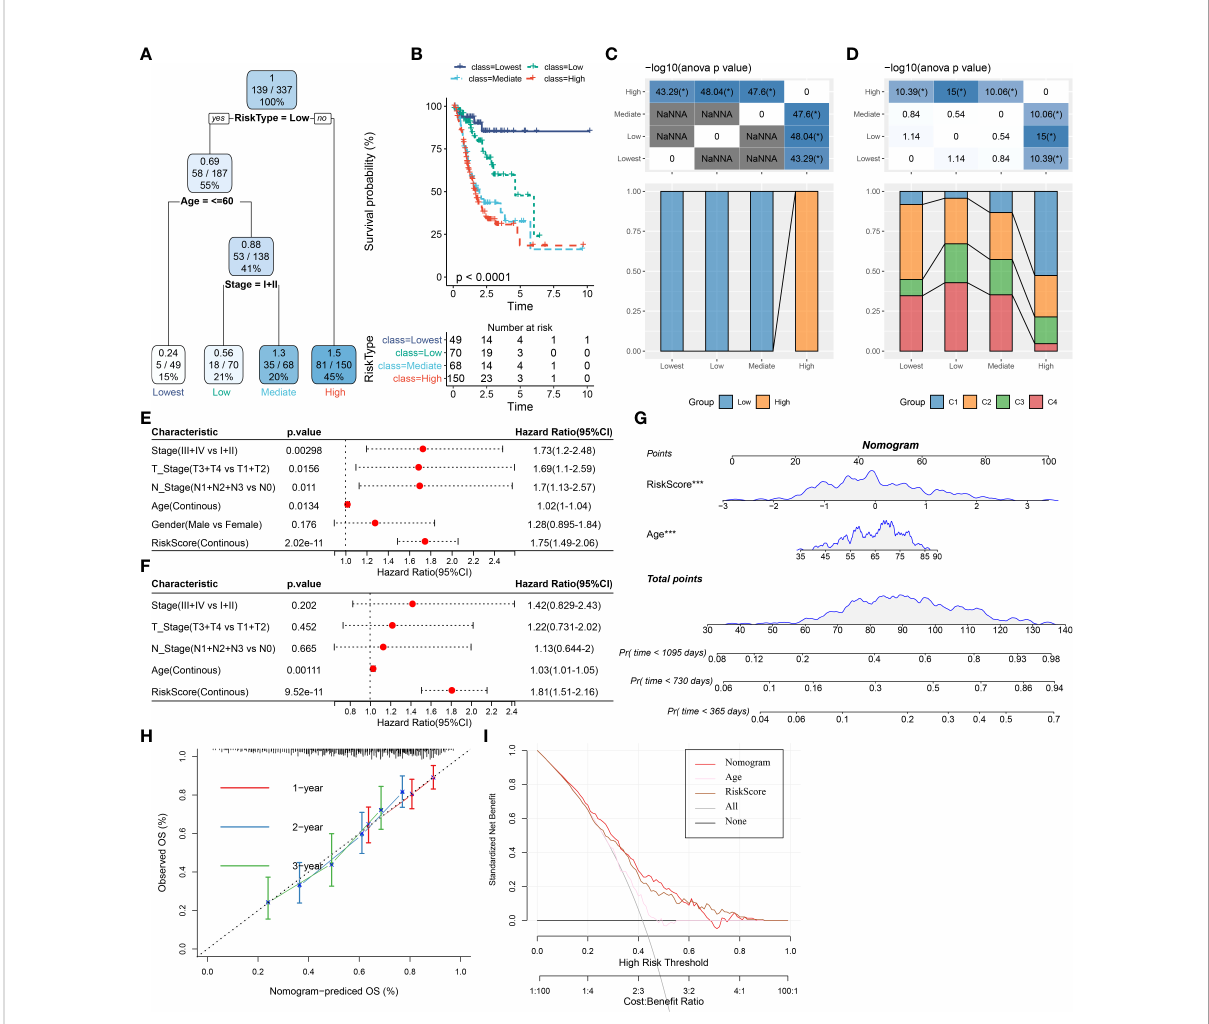
FIGURE 9 Improvement of prognostic model via integrating risk signature and clinical features in the TCGA cohort. (A) Patients with full-scale annotations including risk score, metastatic, gender and age were used to build a survival decision tree to optimize risk strati fi cation. (B) Comparison of overall survival of the four subgroup obtained from the decision tree model. (C) Correlations between the four subgroup and the risk signature. (D) Correlations between the four subgroup and molecular subtypes. (E) Univariate and (F) multivariate Cox analysis of risk score and clinicopathological characteristics in the TCGA cohort. (G) A nomogram combining risk signature and age was generated in the TCGA cohort. (H) Comparison of the calibration curve for 1-, 2-, 3- year overall survival of nomogram. (I) Decision curves for the clinical net bene fi t of each model in comparison to all or none strategies. The x-axis indicated the threshold probability, and the y-axis indicated the net clinical bene fi t. * P <